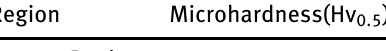
Table 6: Average microhardness of cylindrical component. Region